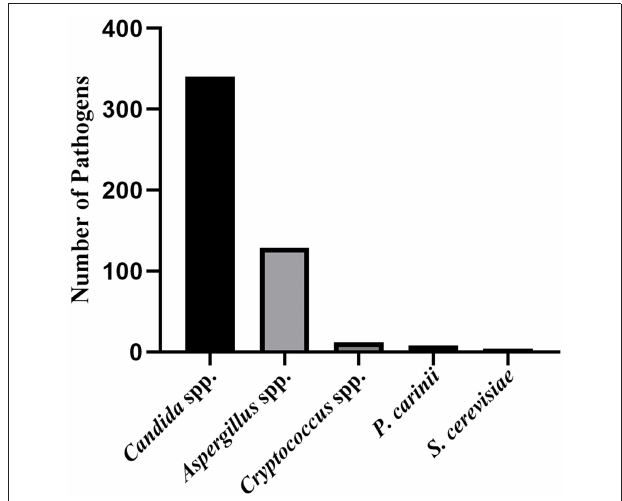
FIGURE 3 | The pathogen composition of IFI after LT. spp, species; P . carinit, Pneumocystis cariniee; S. Cerevisiae, Saccharomyces